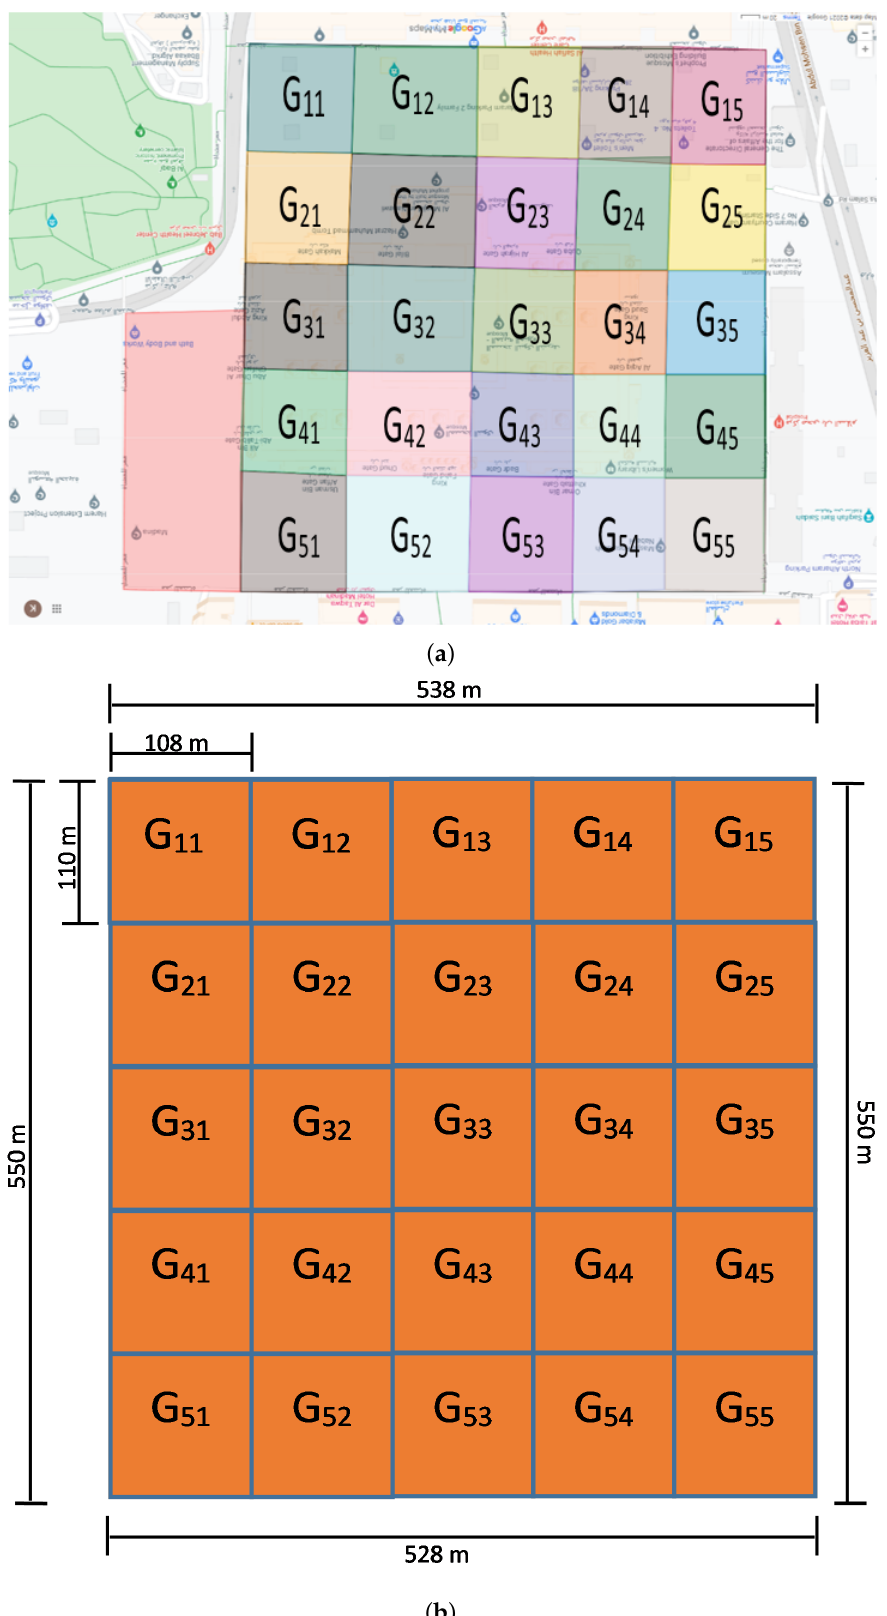
Figure 3. Geofences in Al-Nabawi mosque. ( a ) Geofences for Haram An-Nabavi; ( b ) Dimensions of geofences for Haram